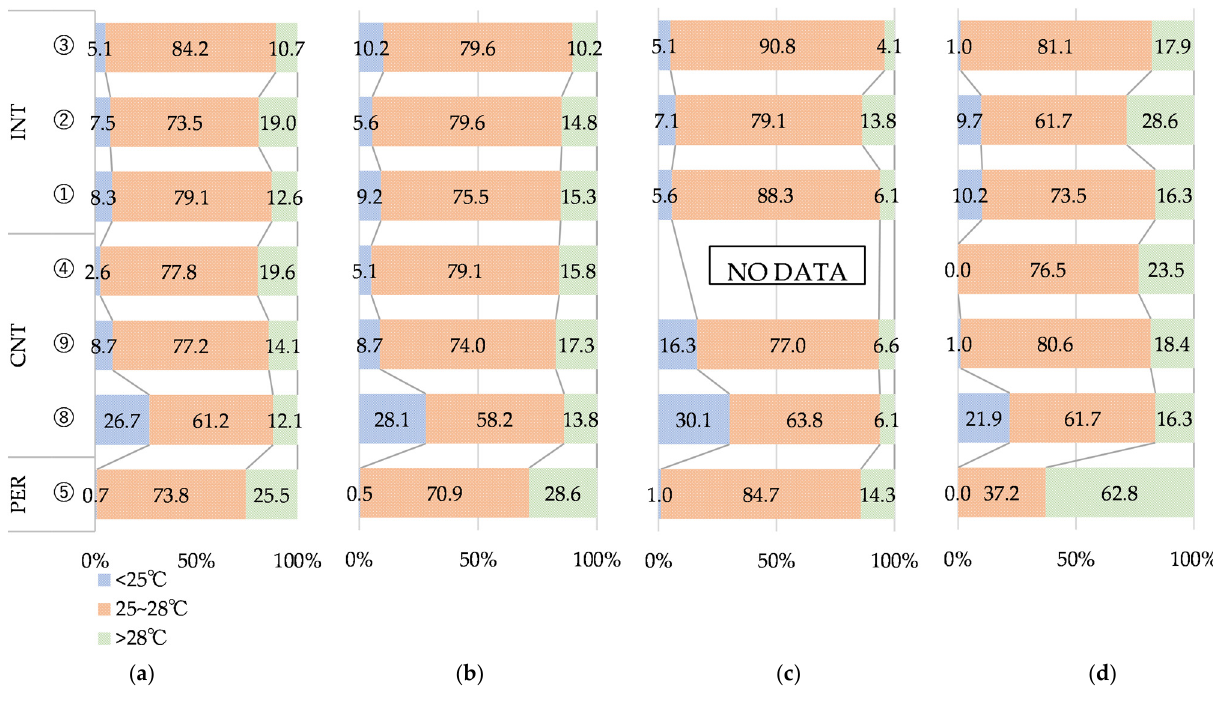
Figure 11. Summer air temperature comfort range percentage for the ( a ) total average and in ( b ) class A, ( c ) class B, and ( d ) class